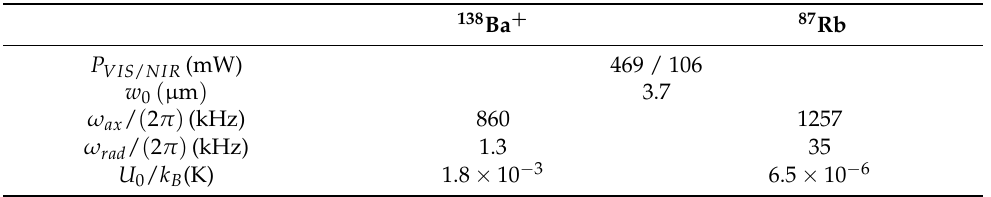
Table 1. Summary of properties of the calculated optical potentials for 138 Ba + and 87 Rb as shown in Figure 7: optical powers P VIS / NIR , 1/ e 2 beam waist radii w 0 , axial/radial trap frequencies ω ax / rad , and trap depths U 0 . The power of the retroreflected VIS beam is 0.05 P VIS , sufficient to superimpose a standing-wave structure yielding high axial trapping